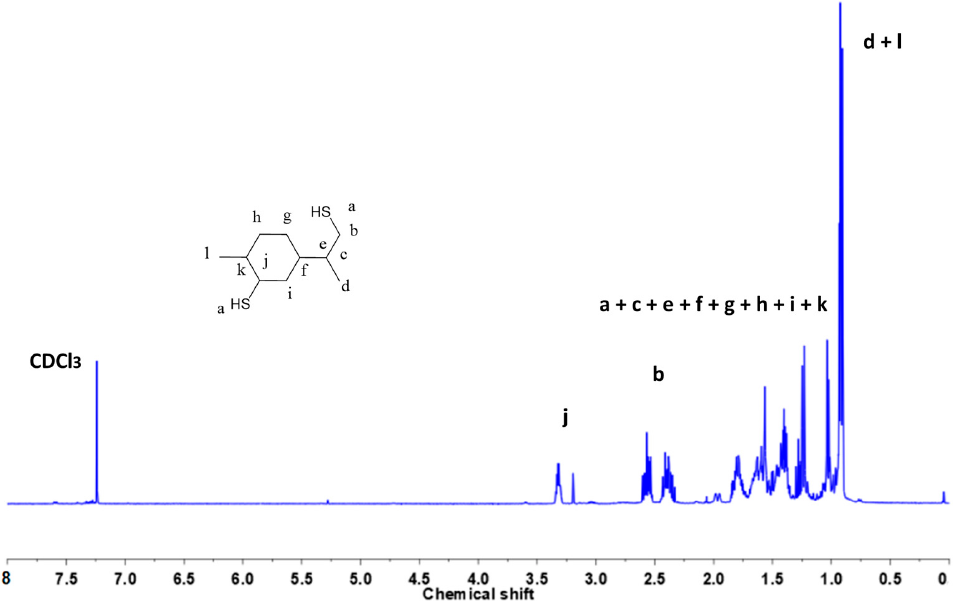
Figure 2. 1 H-NMR spectrum of the dithiol derived from limonene in CDCl 3 .